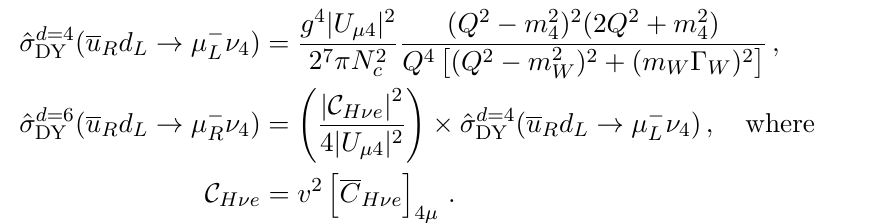
Figure 3 . The normalized LO invariant mass distribution of the ( µν 4 ) -system, when mediated by the DY process at d = 4 , for (L) m 4 = 150 GeV and (R) m 4 = 450 GeV , for (dash), and 100 (dot) TeV. Adapted from ref.